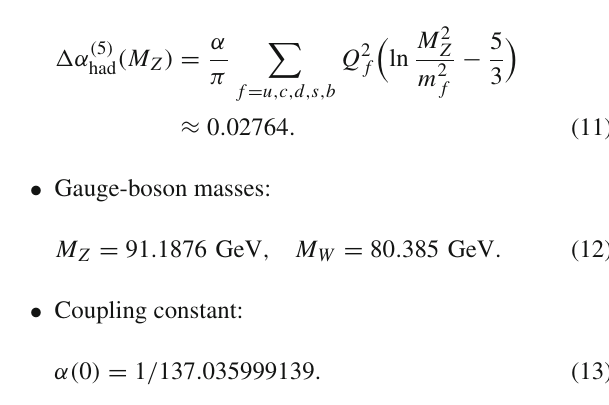
tions.)Forthecharginosandneutralinosweshowthetree-levelvaluesas wellastheirOSmassesinthe CCN[1] , CNN[1,1,3] , CNN[1,1,4] , CNN[2,1,2] , and CNN[2,1,3] scheme as obtained from Eq. (5). Also shown are some values for the complex phase ϕ M scheme